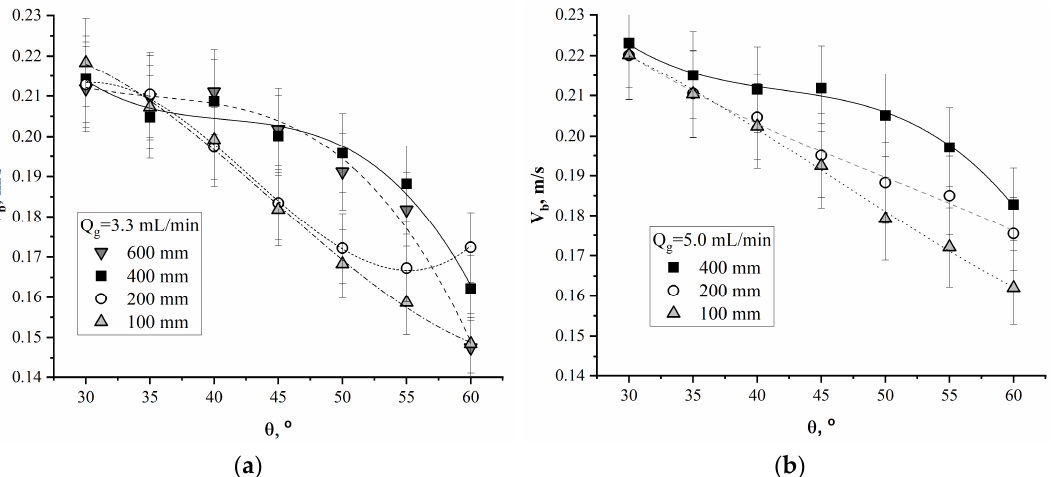
Figure 8. Dependence of the average velocity of gas bubbles as a function of the pipe inclination angle. Gas flow rate ( a ) Q g = 3.3 mL/min; ( b ) Q g = 5.0 mL/min.